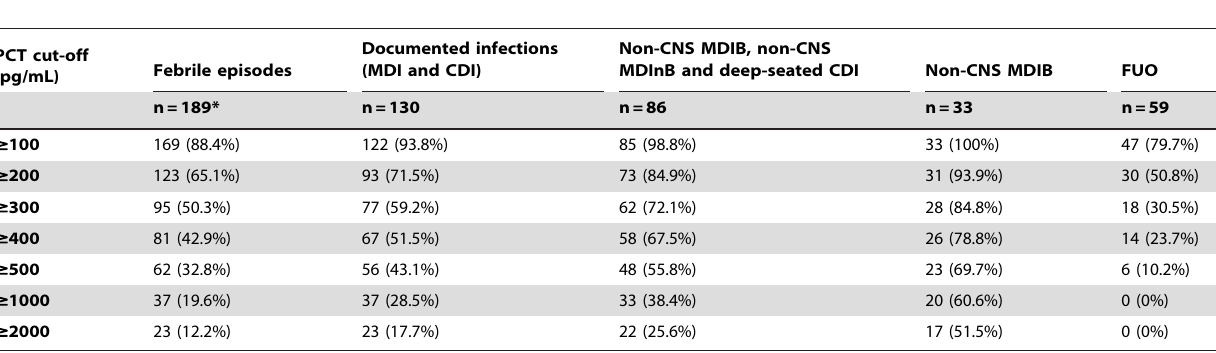
Table 2. PCT on day 2 after onset of fever: positivity at different cut-offs in i) all FE, ii) documented infections (MDIB, MDInB and CDI), iii) subset including non-CNS MDIB, non-CNS MDInB, and deep-seated CDI, iv) non-CNS MDIB, and v)